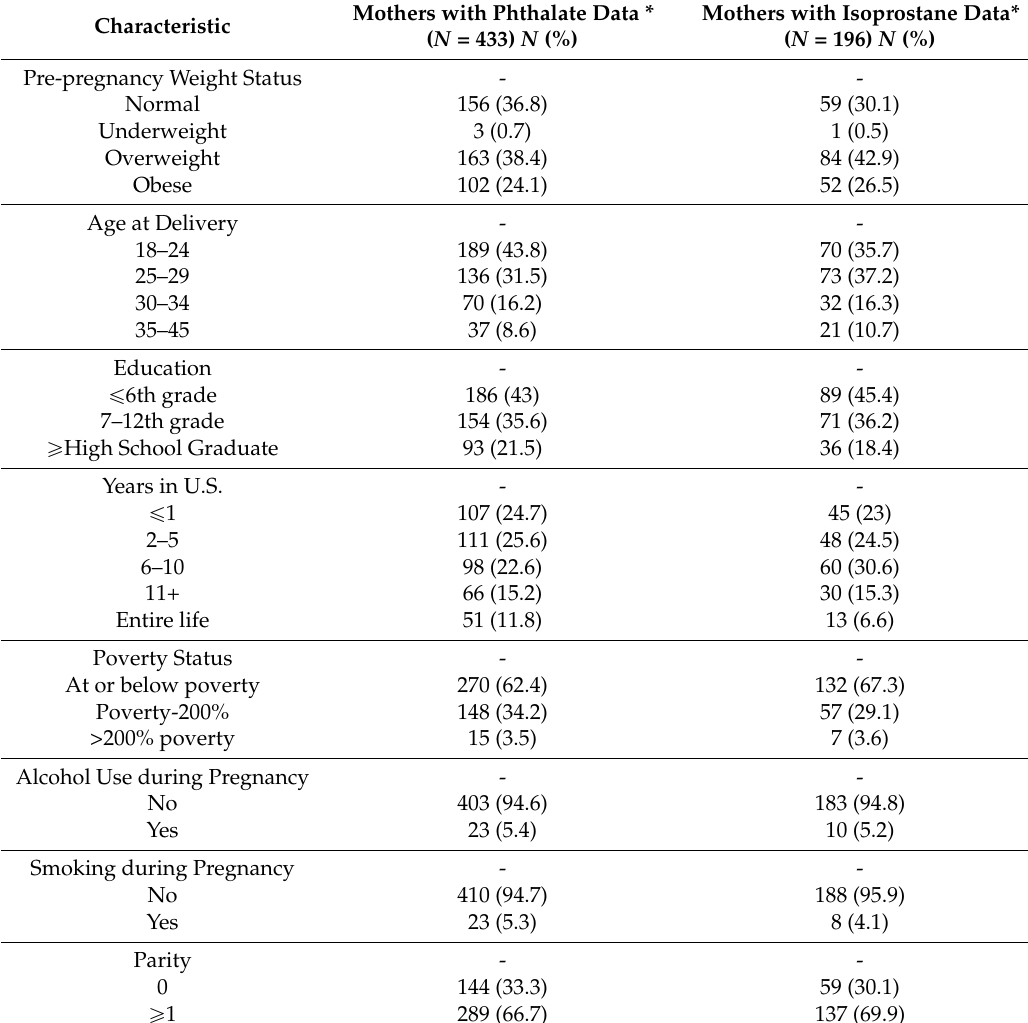
Table 1. Demographic characteristics of Center for Health Assessment of Mothers and Children of Salinas (CHAMACOS) mothers